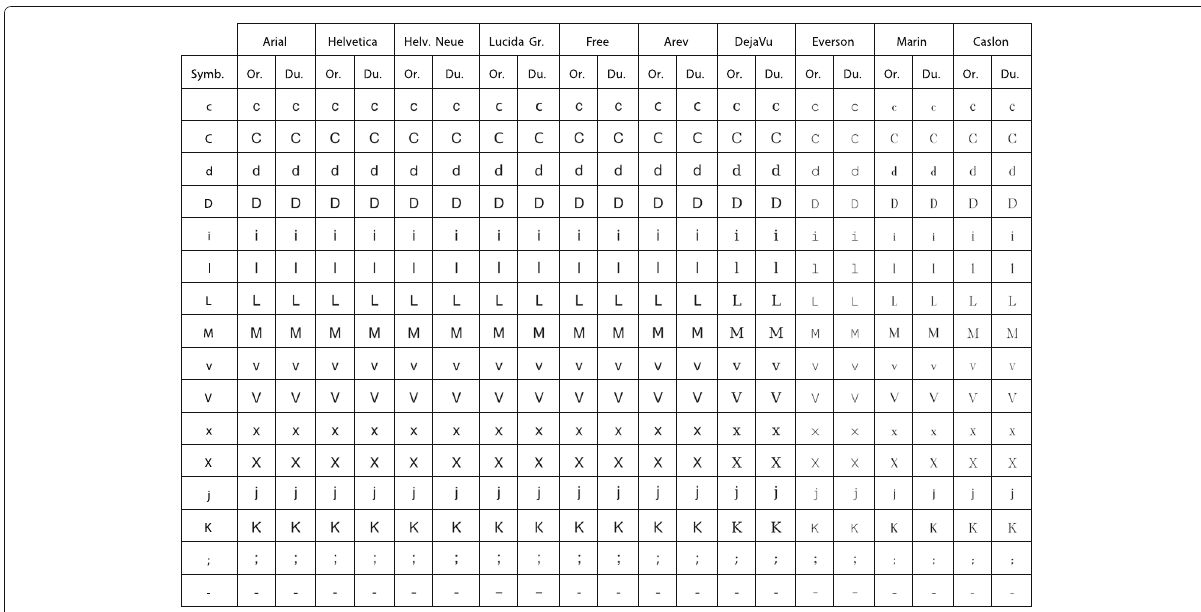
Fig. 11 Confusable symbols rendering. Original (Or.) and duplicate (Du.) symbols rendering for ten font families with Unicode support. The duplicate is indistinguishable for both serif and sans-serif